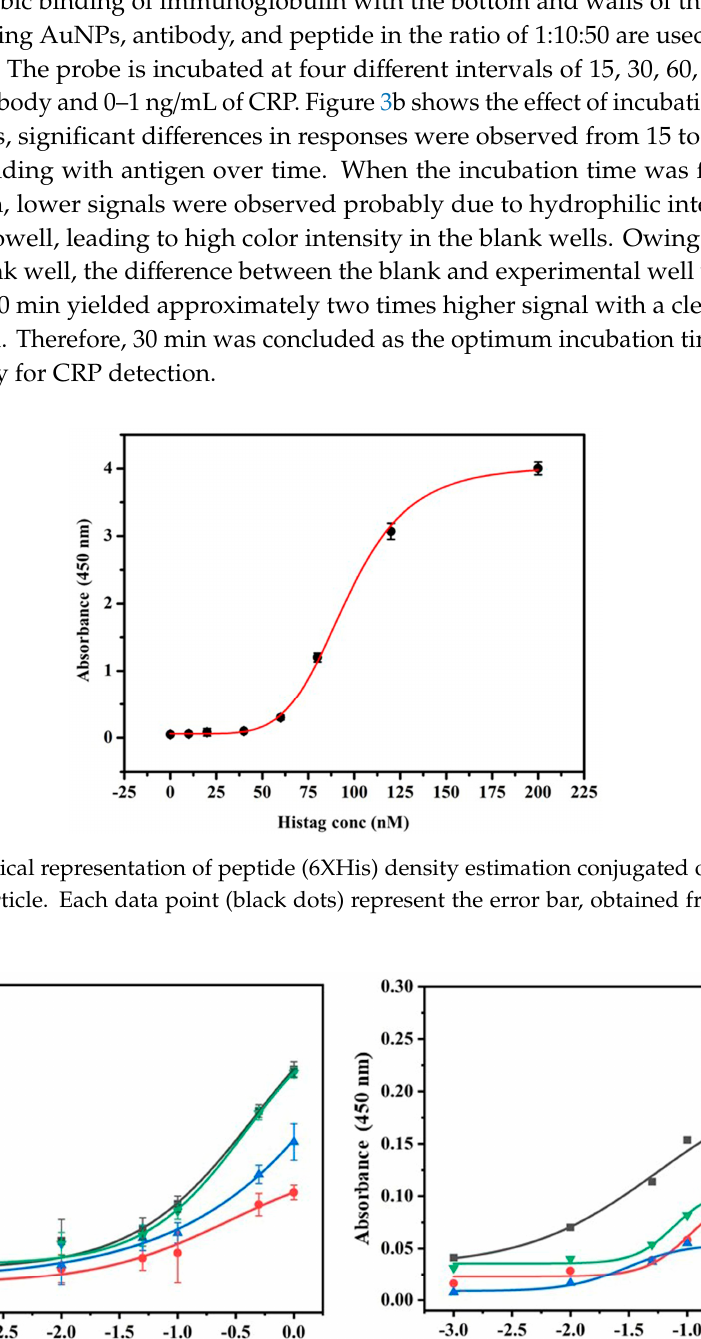
Figure 3. Plot represented the selection of parameters for performing the nanoprobe assay. ( a ) Optimization of capture antibody concentration at three different concentration (2 (red), 3 (blue), 4 (green), and 6 (black) µg/mL), each concentration point is repeated thrice, and ( b ) optimization of probe incubation time at 15 (red), 30 (black), 60 (blue), and 90 (green) min, and 4 µg/mL and 30 min were the finalized capture antibody and incubation time, respectively.